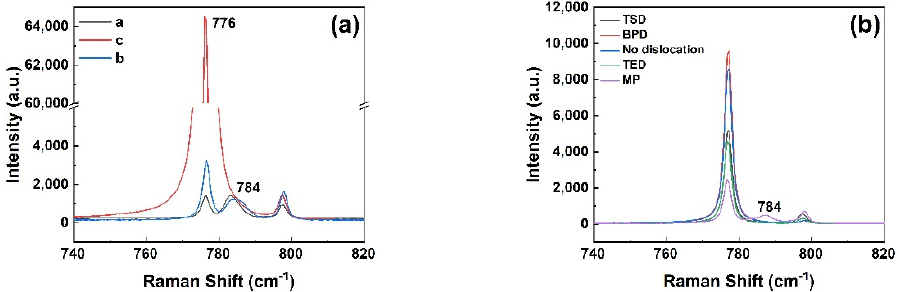
Figure 9. ( a ) Raman spectra of 4H-SiC micropipes; ( b ) Raman spectra of other dislocations and micropipes.